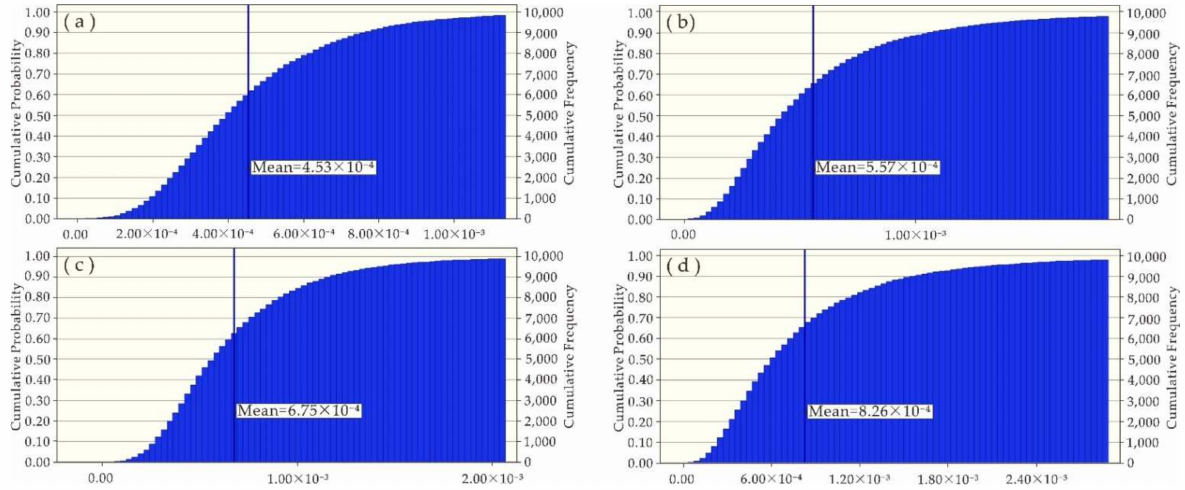
Figure 8. Simulated HQ (Cr) values of ( a ) adults on the left bank; ( b ) adults on the right bank; ( c ) kids on the left bank; and ( d ) kids on the right bank.